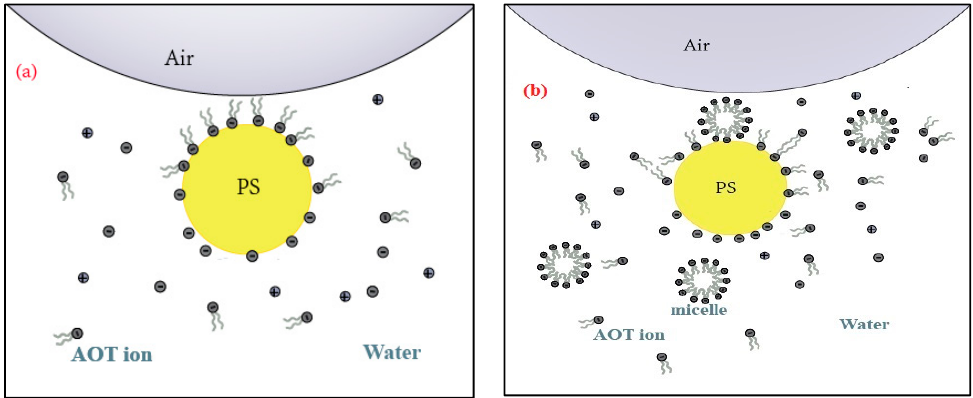
Figure 8. Schematic representation of the charging and surface activation of a PS particle in aqueous AOT solution: ( a ) At low AOT concentration (less than 0.1 mM) and ( b ) at high AOT concentration.